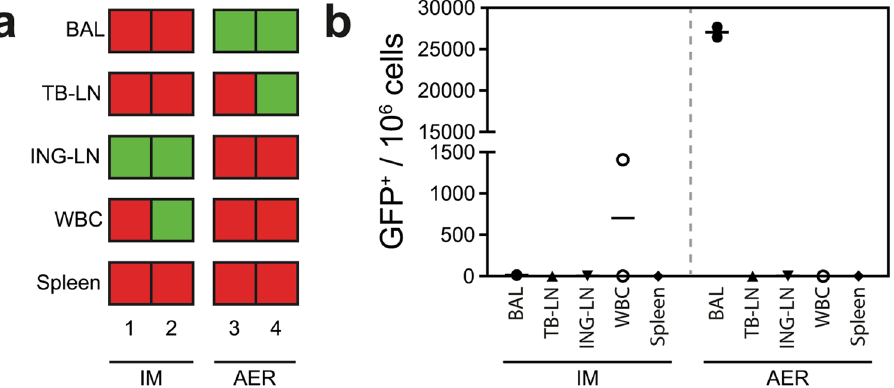
Figure 7. Dissemination of rMVA-GFP + cells in macaques. ( a ) Overview of GFP + cells detected in BAL, TB-LN, ING-LN, WBC or spleen in each individual macaque (n = 2 per group) after IM injection or AER inhalation of rMVA-GFP. Green = GFP + . Red = GFP-negative. ( b ) Frequency of GFP + cells in the respective tissues after IM injection or AER inhalation of rMVA-GFP. Number of GFP + cells per 10 6 total cells is shown, mean of two macaques is